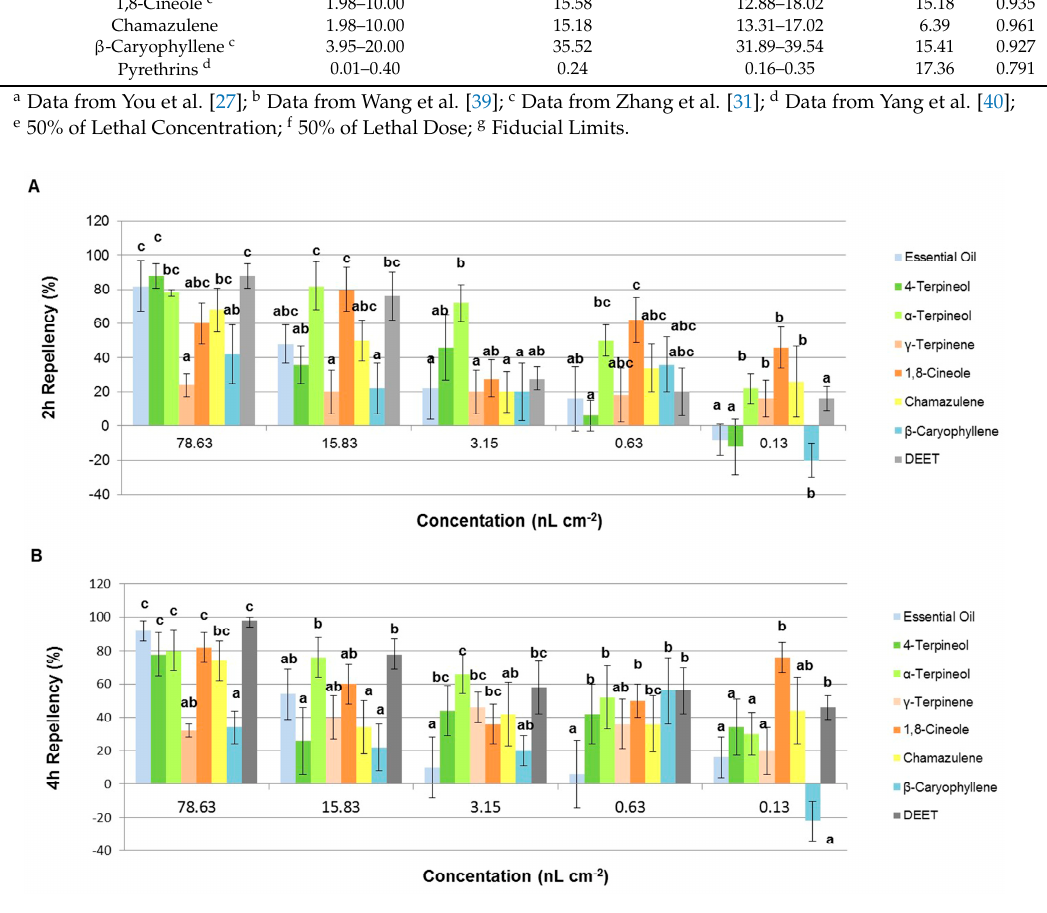
Figure 3. Percentage repellency (PR) of the essential oil and its main constituents against L. serricorne after 2 h ( A ) and 4 h ( B ) treatment. Means in the same column followed by the same letters do not differ significantly ( p > 0.05) in ANOVA and Tukey’s tests. PR was subjected to an arcsine square-root transformation before ANOVA and Tukey’s tests.